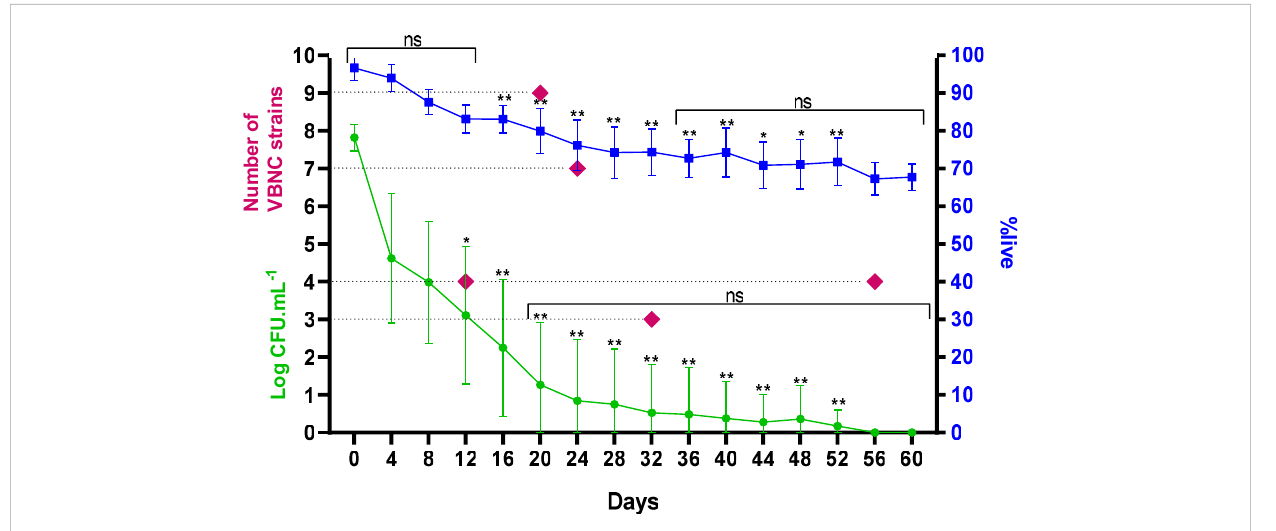
FIGURE 1 Frequency, count and %live of 27 strains of C. jejuni over time under stress until acquisition of the VBNC form. ns, not signi fi cant in comparative analysis between days; *p < 0.05; **p < 0.01: in comparative analysis between strains; using a Kruskal-Wallis test. Error bars indicate the standard deviation for the mean counts and percentages